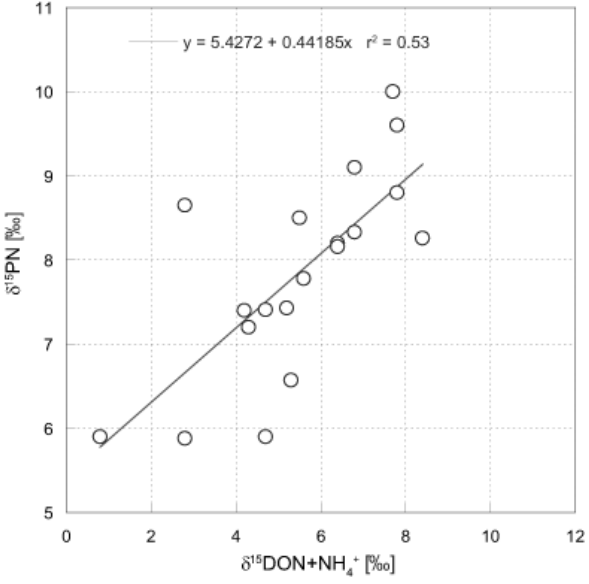
Fig. 5. Relationship between δ 15 DON+NH + Elbe River at the weir of Geesthacht, June 2006–December 2007.